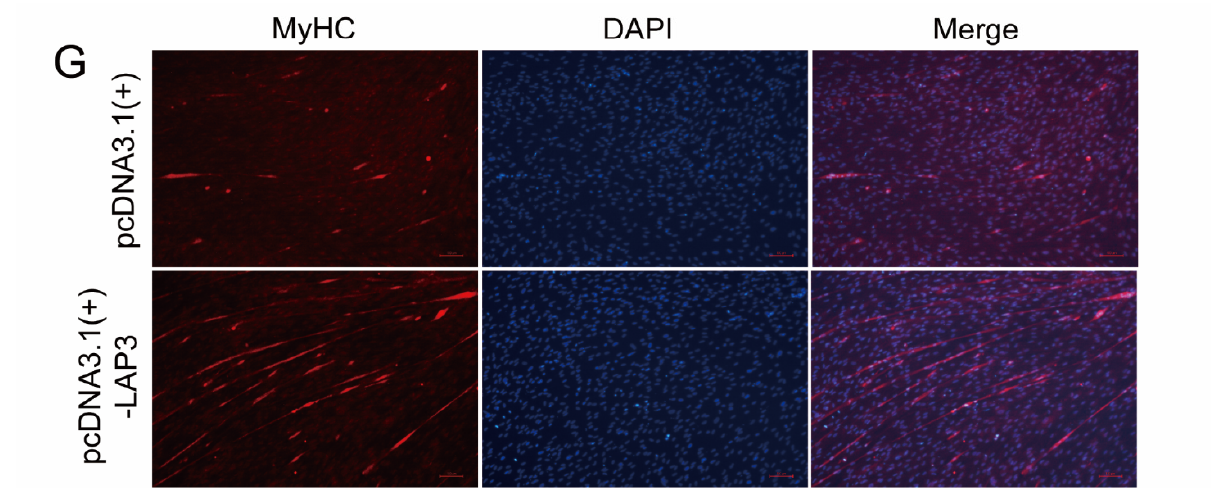
Figure 6. Effects of LAP3 overexpression on embryonic myoblasts differentiation. ( A , B ) The obser- vation of embryonic myoblasts in bright field at 1st, 3rd, 5th, and 7th day (D1, D3, D5, and D7) of differentiation transfected with pcDNA3.1(+)-LAP3 or pcDNA3.1(+) using a fluorescence inverted microscope (100×). ( C – F ) The expression levels of MyoD1 , MyF5 , MyoG , and MRF4 in embryonic myoblasts transfected with pcDNA3.1(+)-LAP3 or pcDNA3.1(+) of at 1st ( C ), 3rd ( D ), 5th ( E ), and 7th ( F ) day (D1, D3, D5, and D7) of differentiation using RT-PCR. ( G ) Immunofluorescence staining of embryonic myoblasts transfected with pcDNA3.1(+)-LAP3 or pcDNA3.1(+) using a fluorescence inverted microscope (100 × ). * p < 0.05; ** p < 0.01, or *** p < 0.001, extremely significant differ- ence; NS p > 0.05, no difference according to Student’s t -test; data are shown as mean ± SEM, n = 3 biological